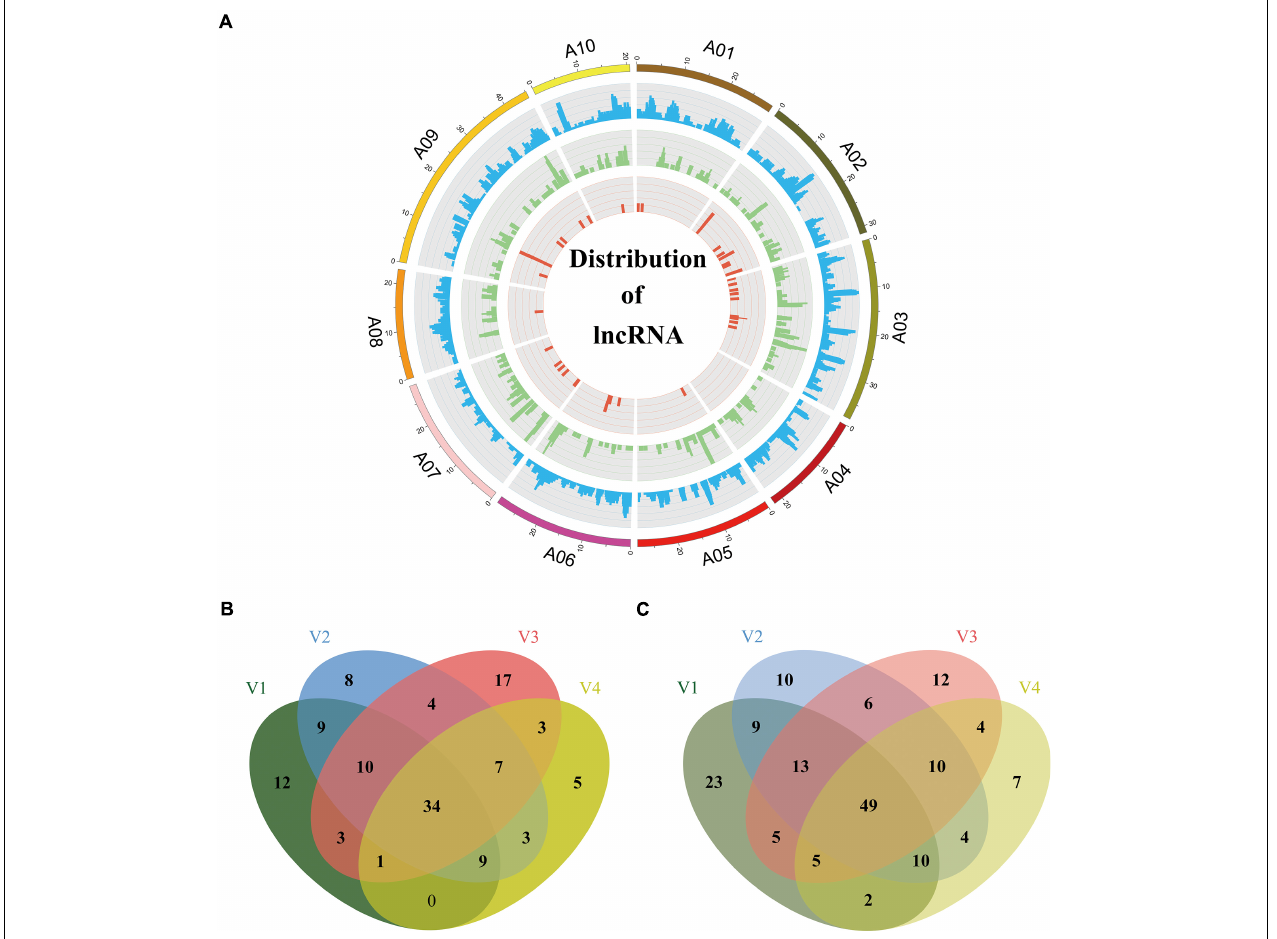
FIGURE 6 | Distribution of lncRNAs and differently expression analysis. (A) Distribution of lncRNAs along each chromosome. From inside to outside, red, green, and blue represents intronic non-coding RNAs (incRNAs), natural antisense transcripts (NATs), and long intergenic non-coding RNAs (lincRNAs). The abundance of lincRNAs, NATs, incRNAs in physical bins of 1 Mb for each chromosome (generated using Circos). Venn diagram, respectively, depicts common and unique lncRNAs up-regulated (B) or down-regulated (C) under different vernalization conditions. V1, V2, V3, V4 indicating the plants vernalized for 7, 14, 21, and 28 days,